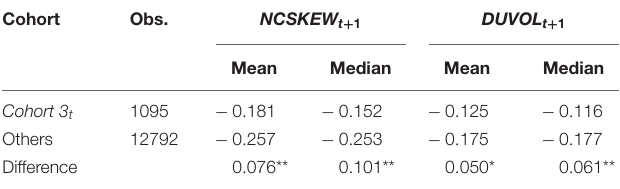
TABLE 5 | Univariate analysis results. TABLE 6 | Regression results of Great Famine experiences on firms’ stock price crash